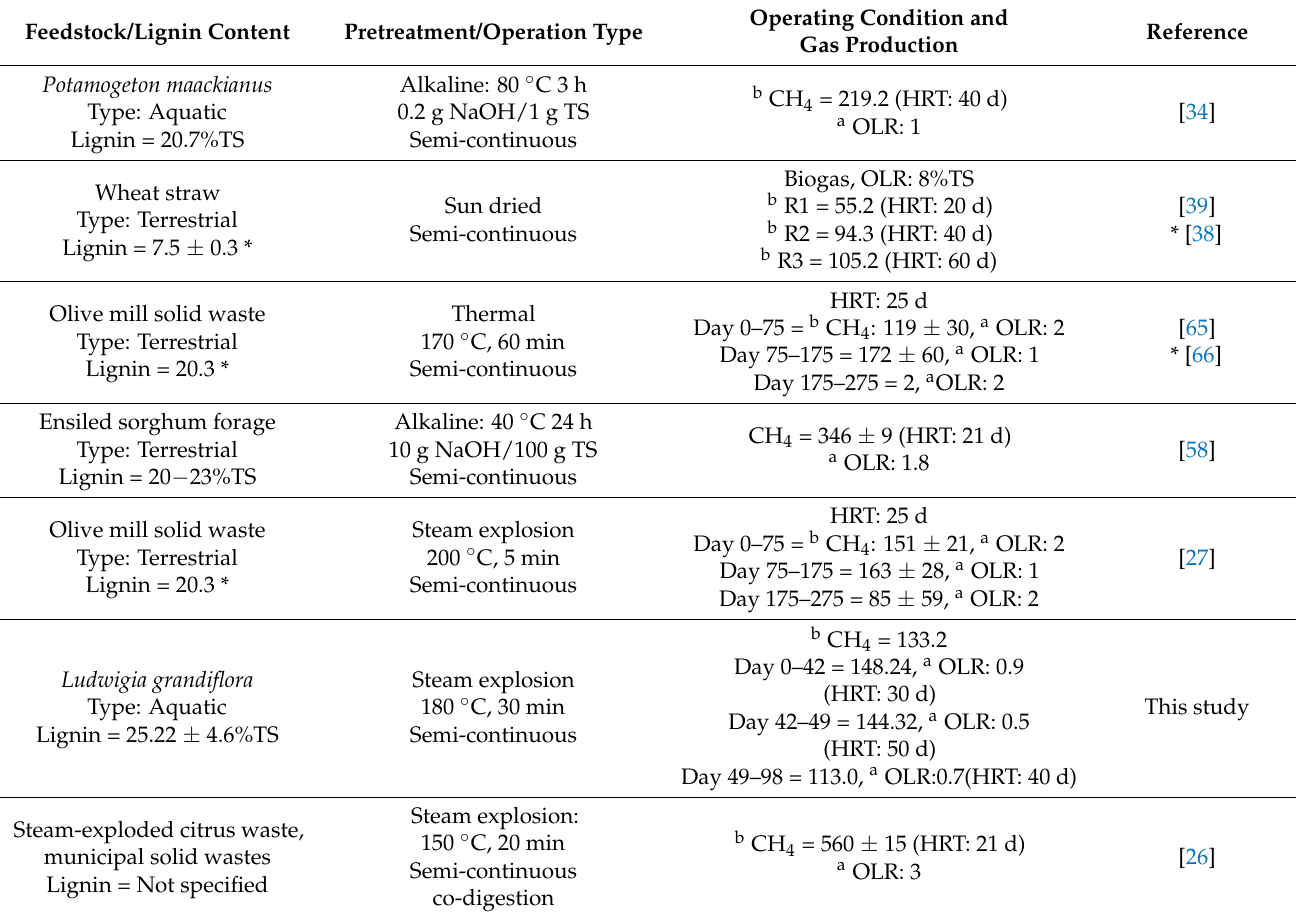
Operating Condition and Gas Production